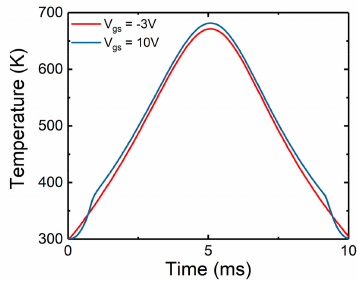
Figure 18. Comparison of the maximum temperature under channel conduction and non-conduction modes when I s = 130